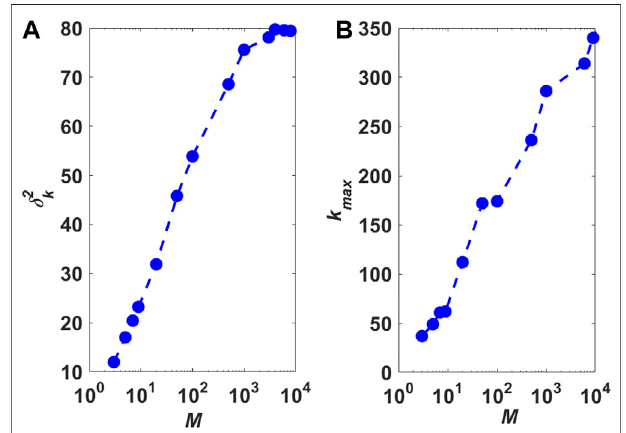
FIGURE 7 | (Color online) Heterogeneity analysis of node degree distribution of local-world evolving networks with different parameter M . (A) σ 2 (cid:2) 10 , 000 nodes and average node k ; (B) k max . All the networks are with N degree 〈 k 〉 (cid:2) 6. Each data point is the average of 50 independent runs. The values of σ 2 k and k max increase monotonously with M , implying that corresponding networks become more heterogeneous in connectivity.